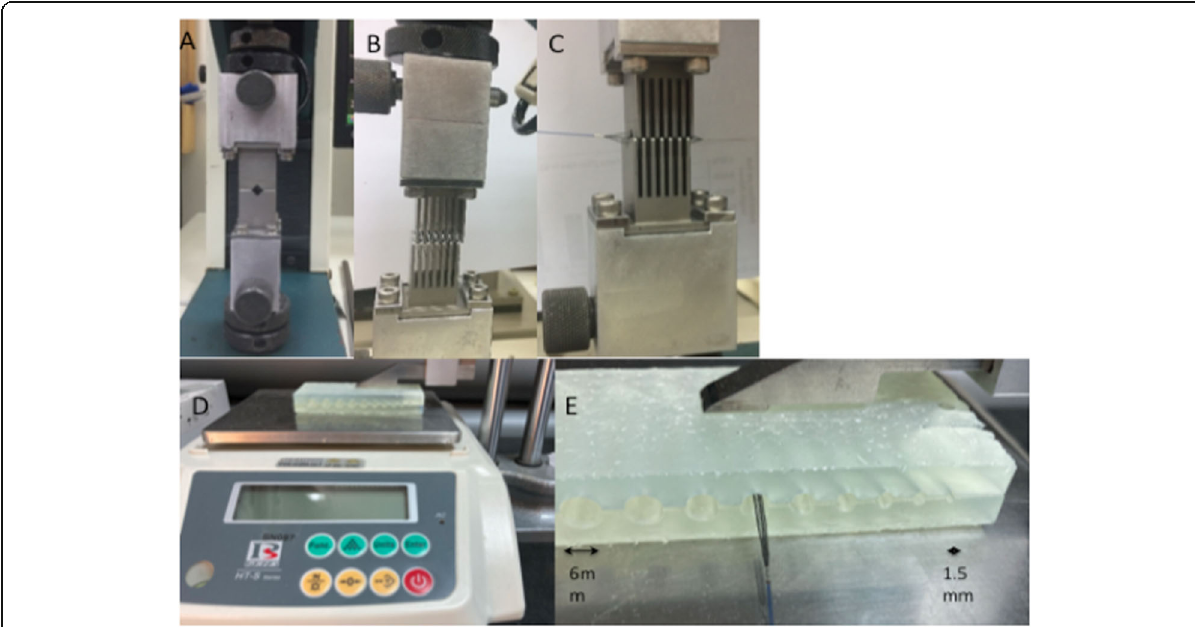
Fig. 1 The H5KT (Tinius Olsen, Horsham, PA, USA) tensile machine connected to two interlocking combed plates (Fig. 1 A and B ) was used to determine the COF. Each of the devices were placed into the aperture created by the two interlocking plates Fig. 1 C ). Device set-up to test the force generated by the different devices when inserted into ‘ cylinders ’ of varying diameter is shown in Figs. 1 D and